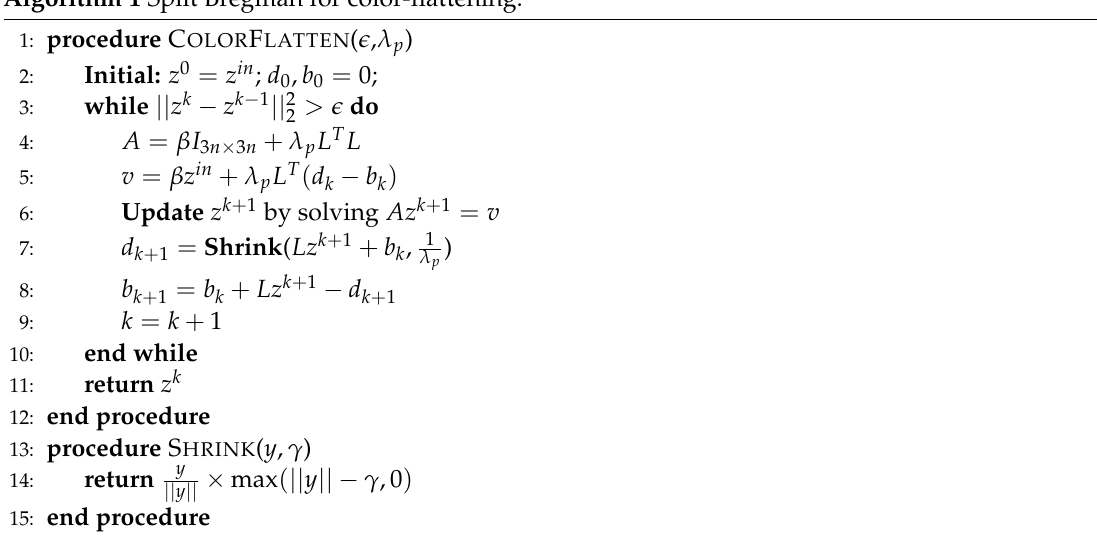
Algorithm 1 Split Bregman for